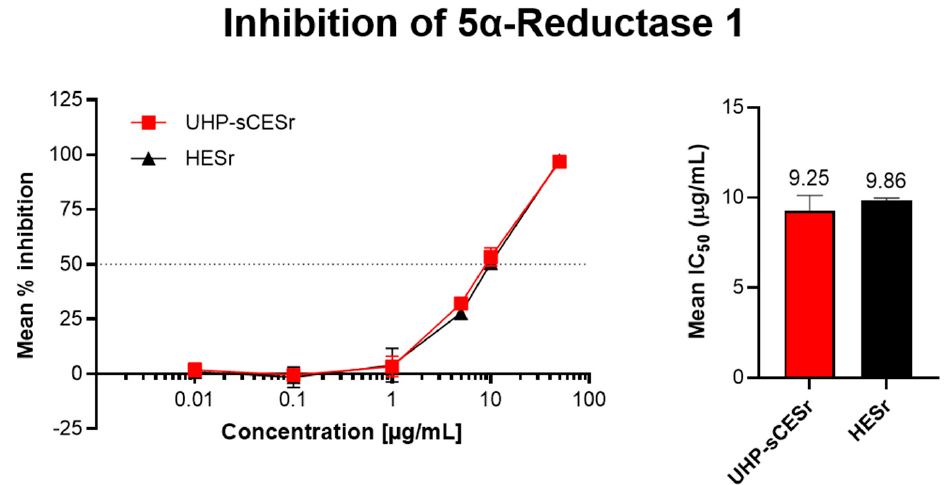
Figure 1. Inhibition of 5 α R-1 by an ultrahigh-pressure supercritical carbon dioxide extract of Serenoa repens (UHP-sCESr; lot 170710-PEG) and hexanic extract of S. repens (HESr; lot G06743). For the mean IC 50 values, error bars represent the standard error.